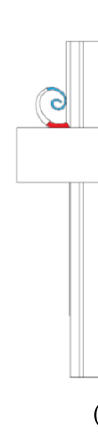
Figure 5. The shape of specimen. ( a ) Physical map; ( b ) sketch map.